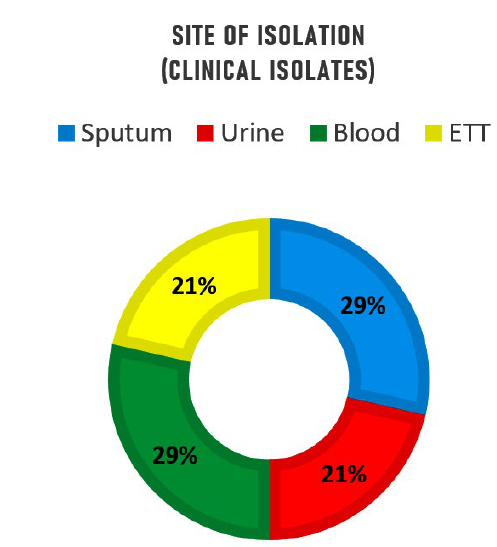
Fig. 2. The sliced pie chart represents the percentage of the clinical bacterial